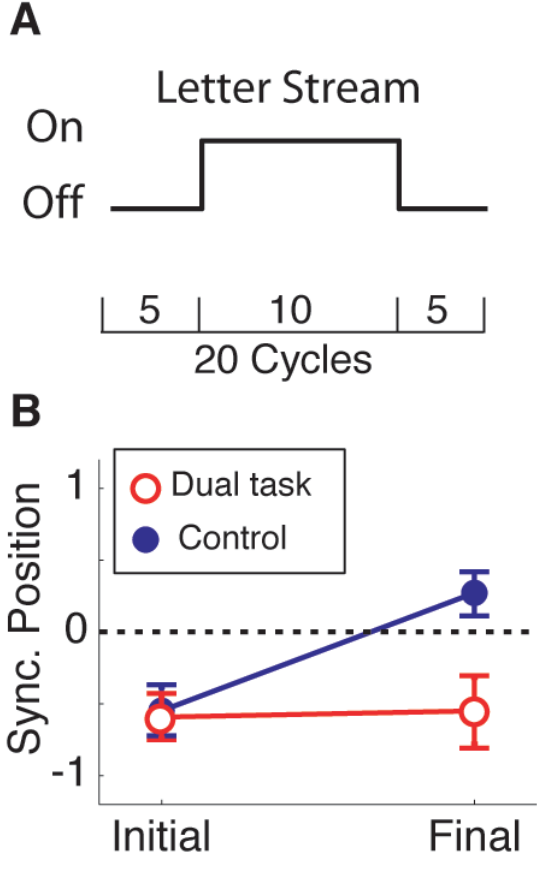
Figure 5. Attentional distraction experiment. A . A trial consisted of 20 cycles, and the letter stream was presented during the middle ten trials. The observers were asked to report the position of the position of perceptually synchronous disk for the initial five and the final five cycles. B . The perceptually synchronous positions for the initial and final cycles are plotted separately for the dual-task condition (open red circles) and for the single-task condition (solid blue circles). The error bars indicate one SEM